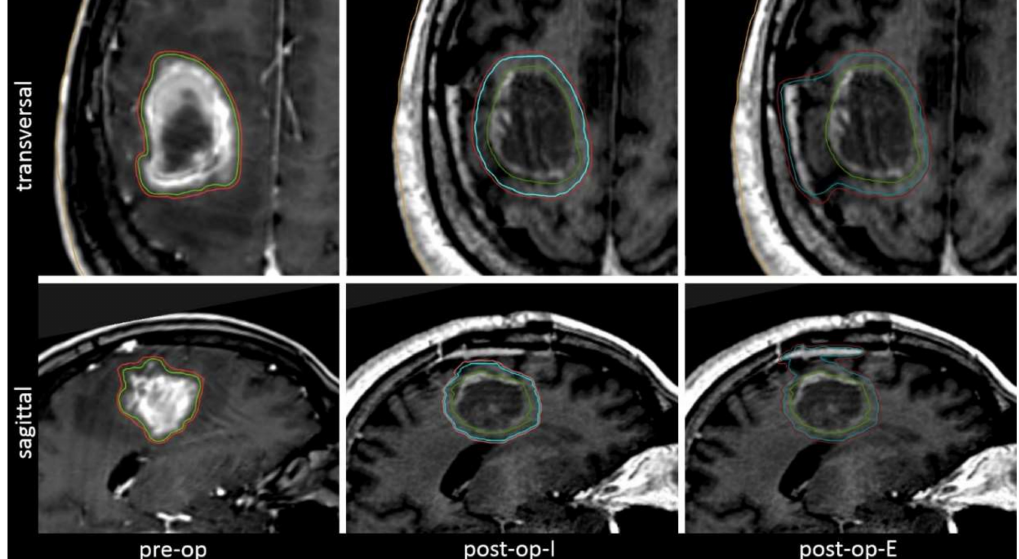
Figure 1. The three clinical scenarios regarded for volumetric and dosimetric analysis, illustrated by means of a representative example. The pre-operative (pre-op) setting includes only a minimal margin. The post-operative settings target either the involved field (cavity + 3 mm, post-op-I) or an extended field that includes the complete surgical tract